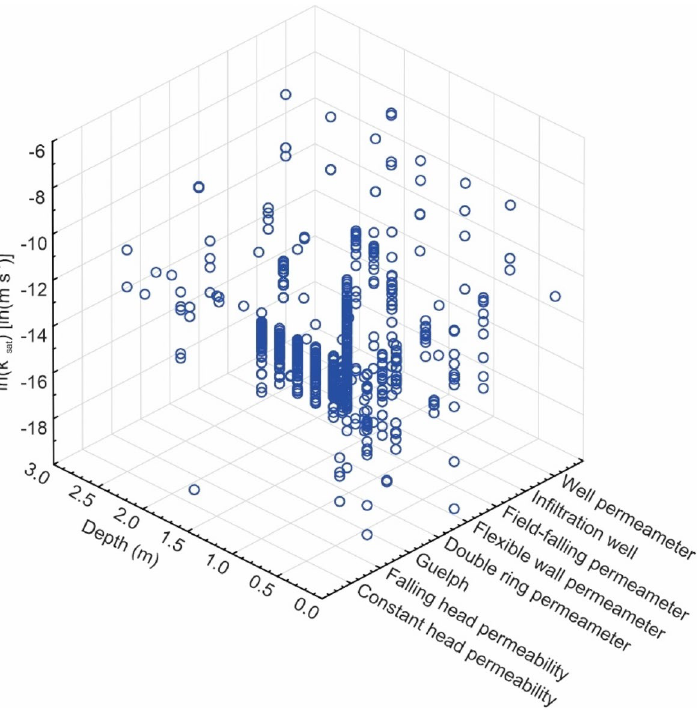
Figure 8. Distribution of the saturated hydraulic conductivity of the lateritic soil by depth range and type of test by different authors, considering all the researched data.